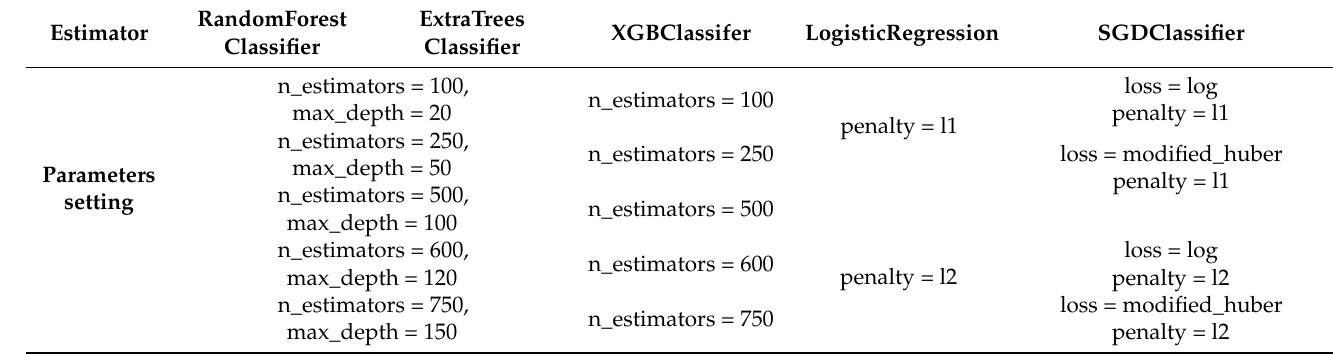
Table 10. Parameters adjusted in each